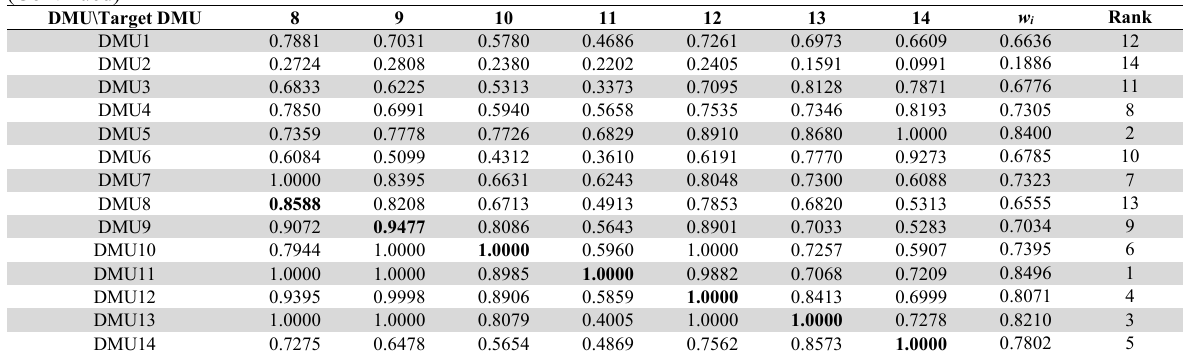
(Continued) DMU\Target DMU